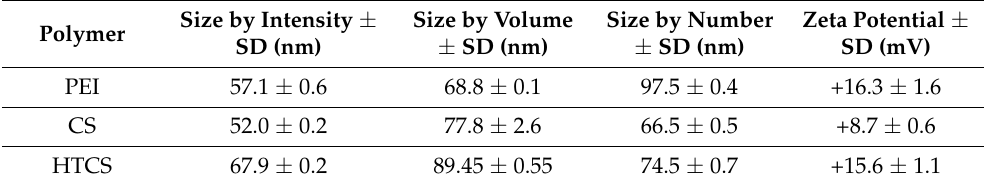
Table 1. Particle size and zeta potential of polyplexes formed with PEI (as a control), CS, and HTCS in HBG buffer at a C/P ratio of